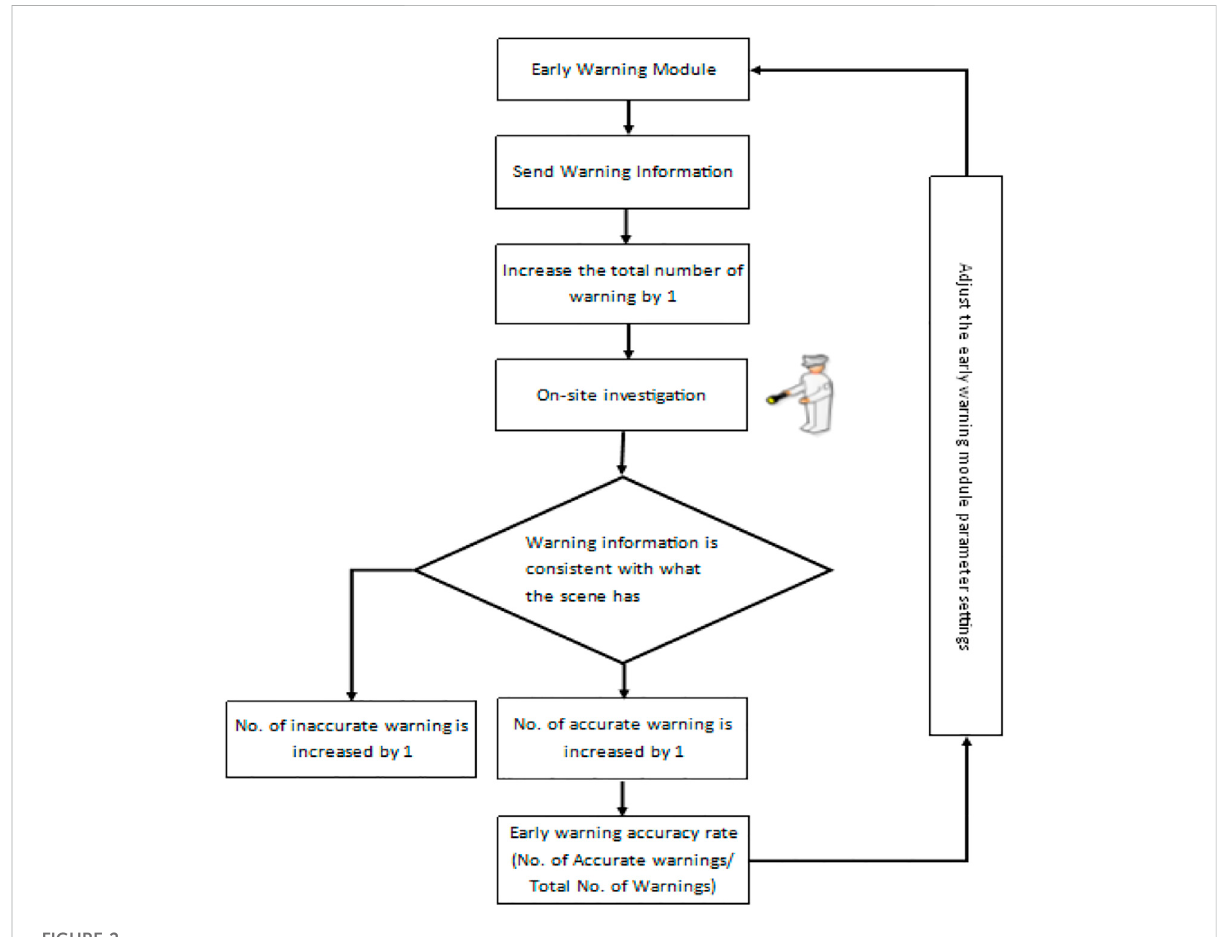
FIGURE 2 Model parameter adjustment